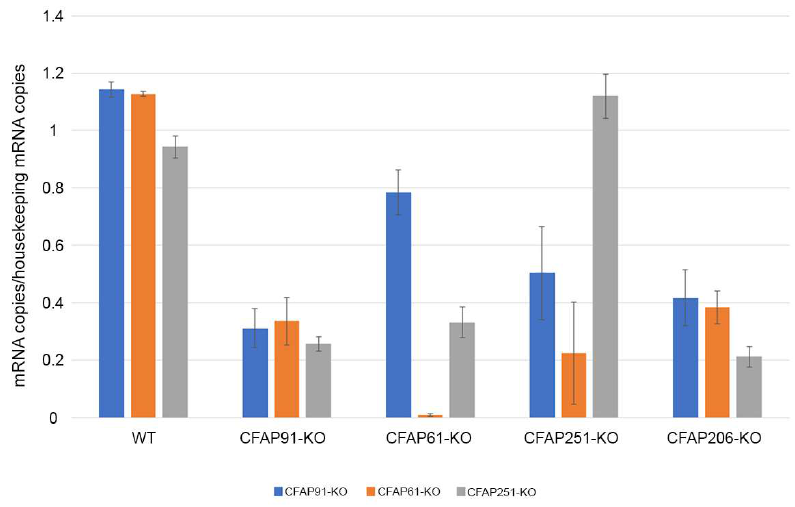
Figure 7. Real-time RT-PCR analyses of the levels of expression of CFAP61 , CFAP91 , and CFAP251 . GCP4 was used as a housekeeping gene.